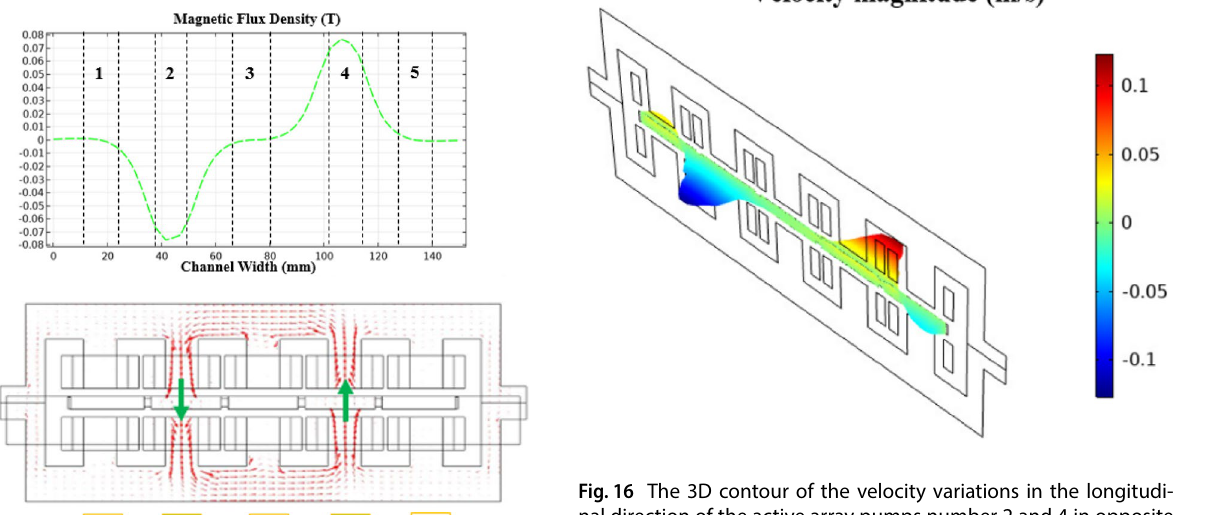
Fig. 16 The 3D contour of the velocity variations in the longitudi- nal direction of the active array pumps number 2 and 4 in opposite